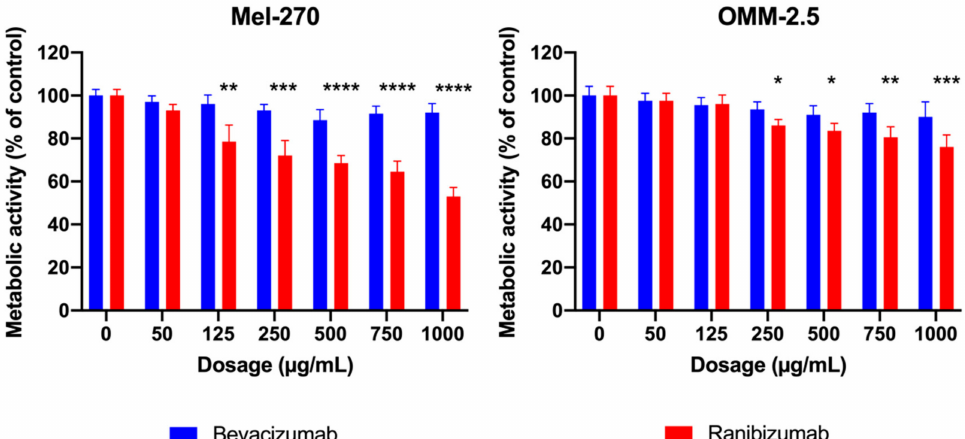
Figure 1. MTT assay demonstrating the metabolic activity of Mel-270 and OMM-2.5 cells after incubation with varying doses of bevacizumab and ranibizumab for 1 day. Bevacizumab did not show any significant impact on metabolic activity in either cell type. Ranibizumab exerted a dose- and cell-type-dependent e ff ect, with 125 µ g / mL being su ffi cient to reduce the metbolism of Mel-270 *** p < 0.001, **** p <